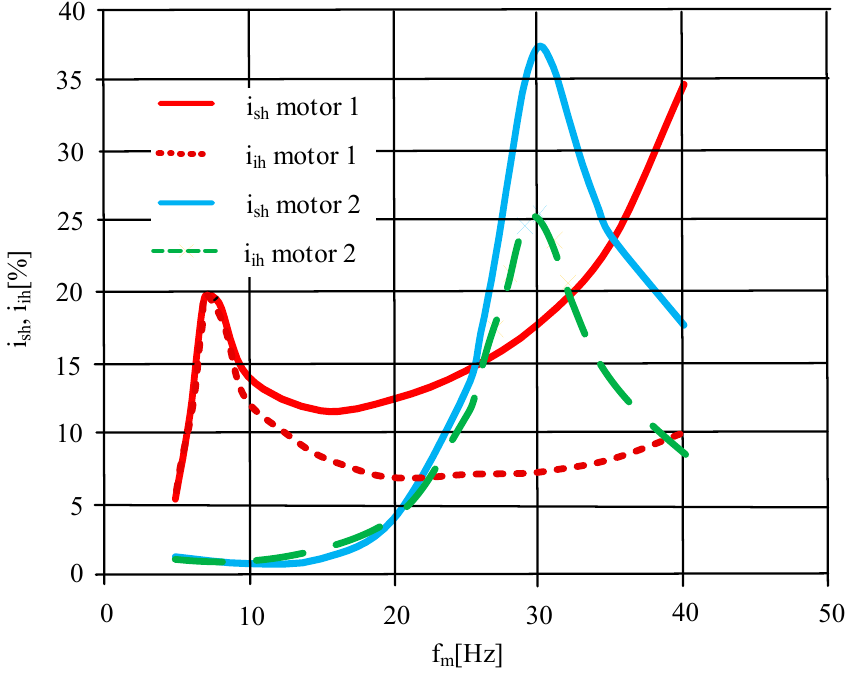
Figure 12. Current subharmonics and interharmonics versus the frequency of voltage fluctuations for the phase modulation ( φ sh = 0 ◦ , φ ih = 180 ◦ ) and the load with a negligible moment of inertia. The frequency components are related to the rated current.